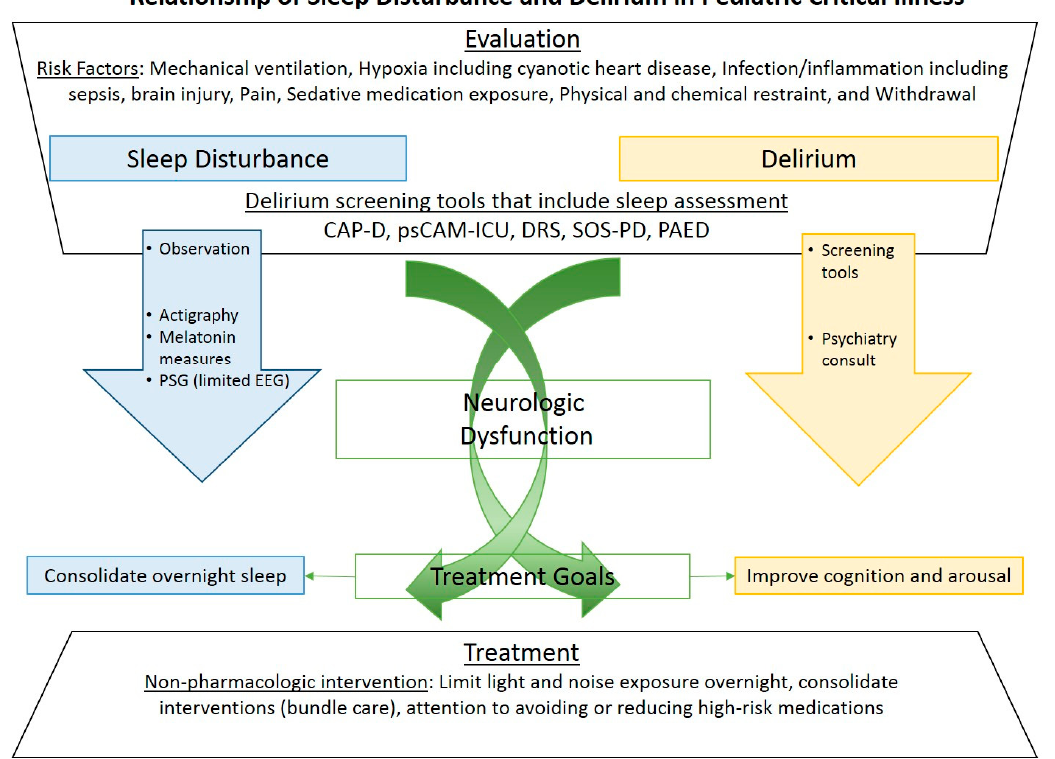
Figure 1. The first step in evaluating sleep disturbance and delirium are recognizing the similar risk factors. Next, identification of sleep disturbance and delirium are distinct except for a few delirium screening tools. Distinct measurements for sleep disturbance and delirium are noted by the large arrows with associated treatment goals noted by the corresponding color boxes. Finally, noted at the bottom, non-pharmacologic intervention for both sleep disturbance and delirium are the same.